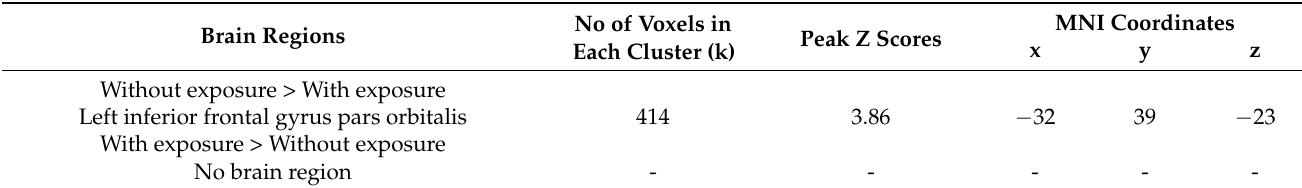
Table 5. Brain regions showing significant contrasts in volume between men with and without perinatal dioxin exposure after adjusting for total intracranial volume and age (FDR-corrected at p < 0.05). Brain Regions